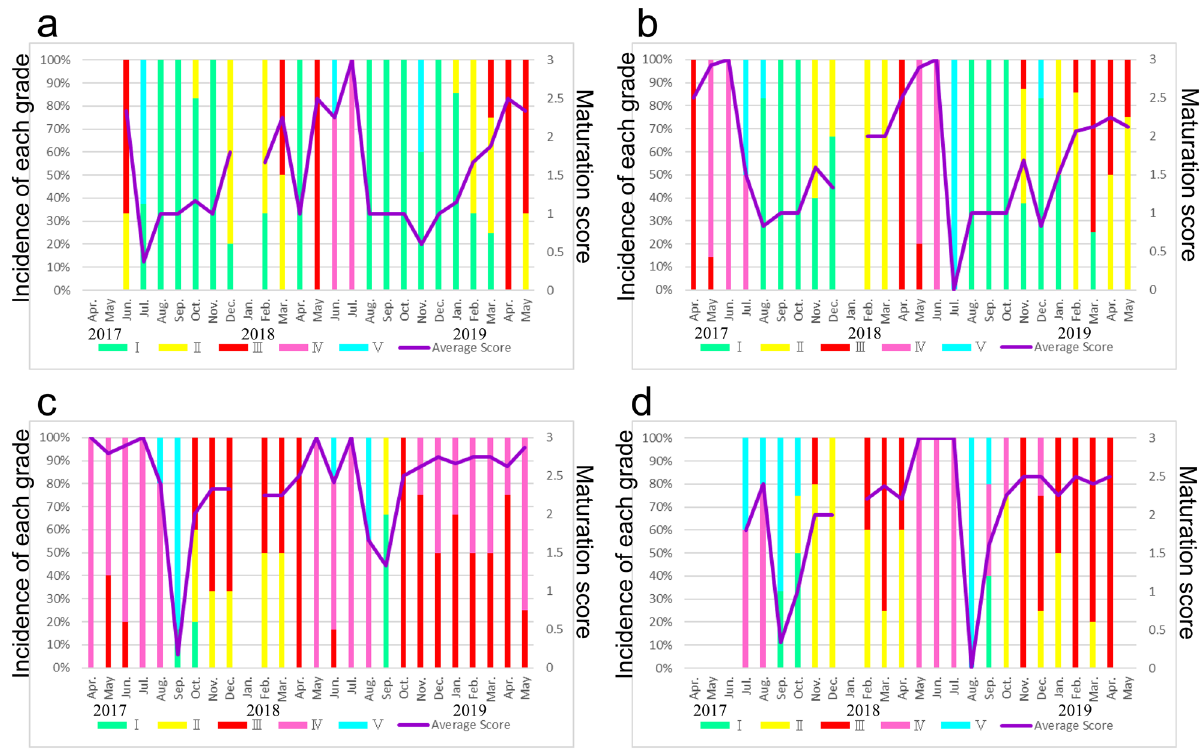
Figure 4. Time series of maturation scores and development grades of male Thais clavigera and Thais bronni collected at ( a ) Hiraiso ( T. clavigera ), ( b ) Tomioka ( T. clavigera ), ( c ) Okuma ( T. clavigera ), and ( d ) Okuma ( T. bronni ).